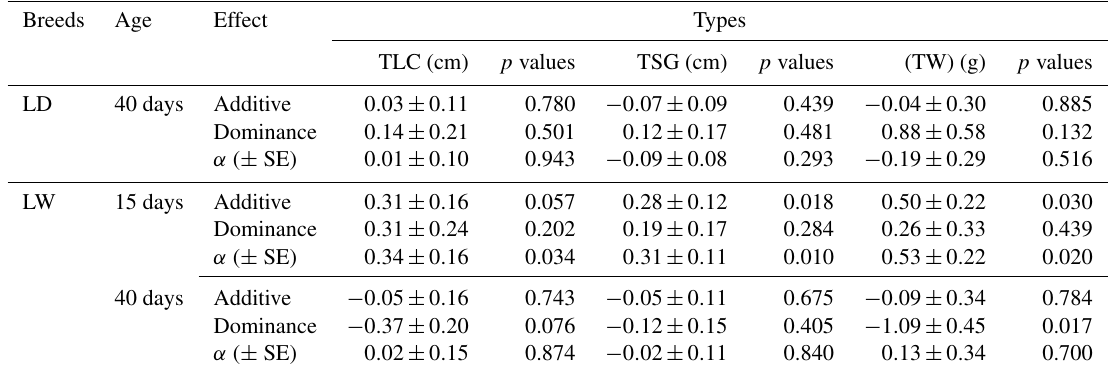
Table 4. Additive, dominance, and allele substitution ( α ) effects of the A47A mutation in pig TMEM95 .